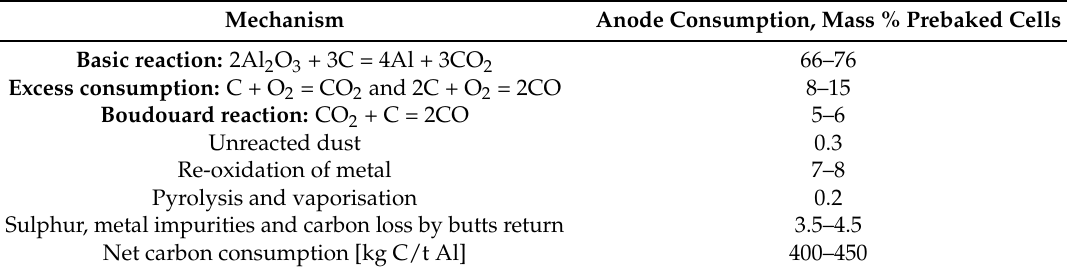
Table 1. Carbon anode consumption.